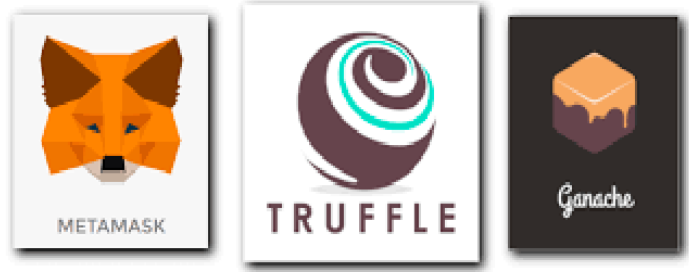
Figure 9. Blockchain implemented on Raspbian OS.